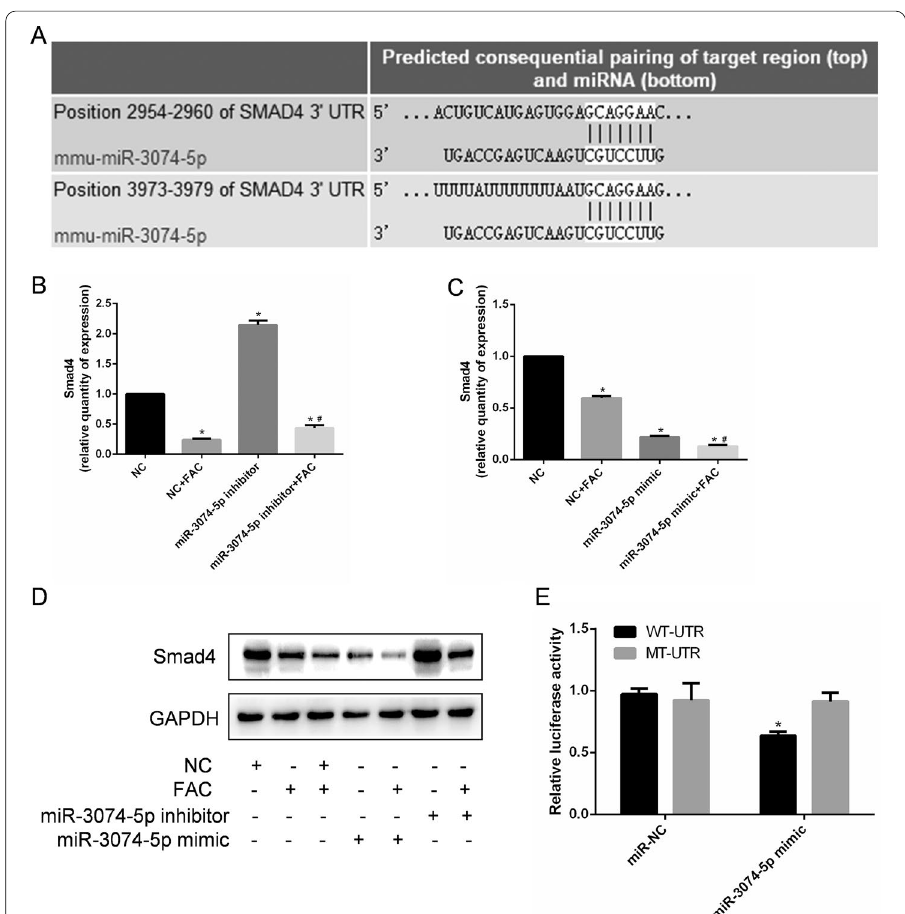
Fig. 4 Smad4 mRNA and protein were decreased in MC3T3‑E1 cells under iron overload and were inversely correlated with miR‑3074‑5p expression. A Bioinformatics analysis showed that miR‑3074‑5p might bind to 3 ʹ UTR region of Smad4. B MC3T3‑E1 cells were transfected with the miR‑3074‑5p inhibitor and NC separately and treated with or without 1.8 mM FAC. Smad4 mRNA was quantified by qRT‑PCR. C Cells were transfected with the miR‑3074‑5p mimic and NC separately and treated with or without 1.8 mM FAC. Smad4 mRNA was quantified by qRT‑PCR. * P < 0.05 vs. the NC group. # P < 0.05 vs. the NC FAC group. D MC3T3‑E1 cells were + transfected with miR‑3074‑5p mimic, miR‑3074‑5p inhibitor and negative control separately and treated with or without 1.8 mM FAC. Smad4 protein was detected by qRT‑PCR. E The dual‑luciferase report assay demonstrated that miR‑3074‑5p directly targets the 3 ʹ UTR of Smad4. The miR‑3074‑5p mimic repressed